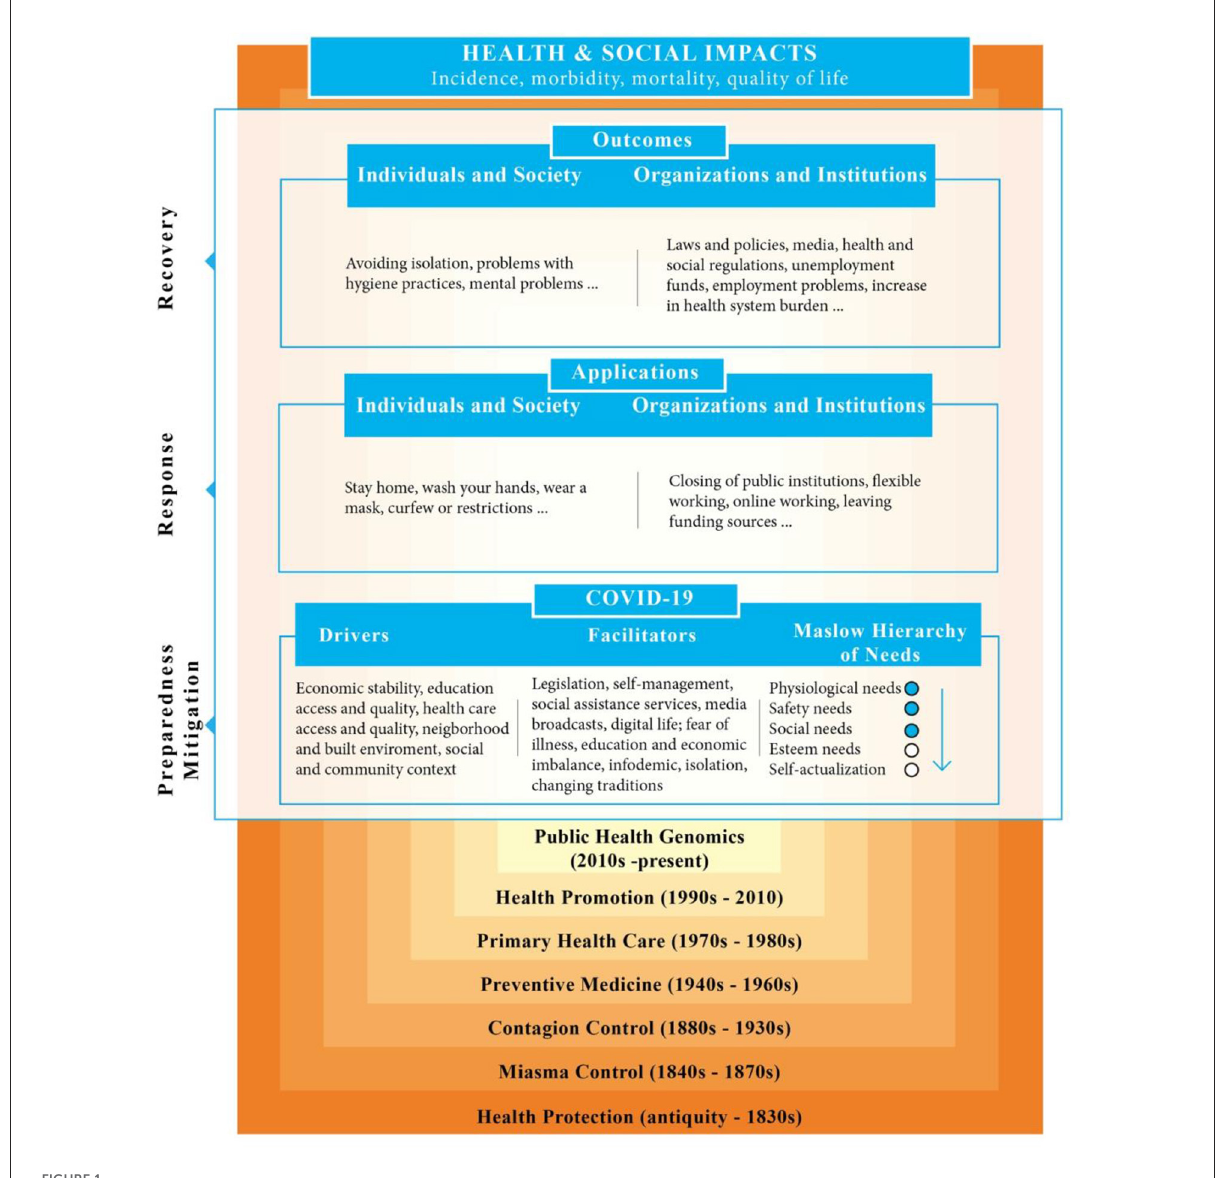
FIGURE1 COVID-19 development process